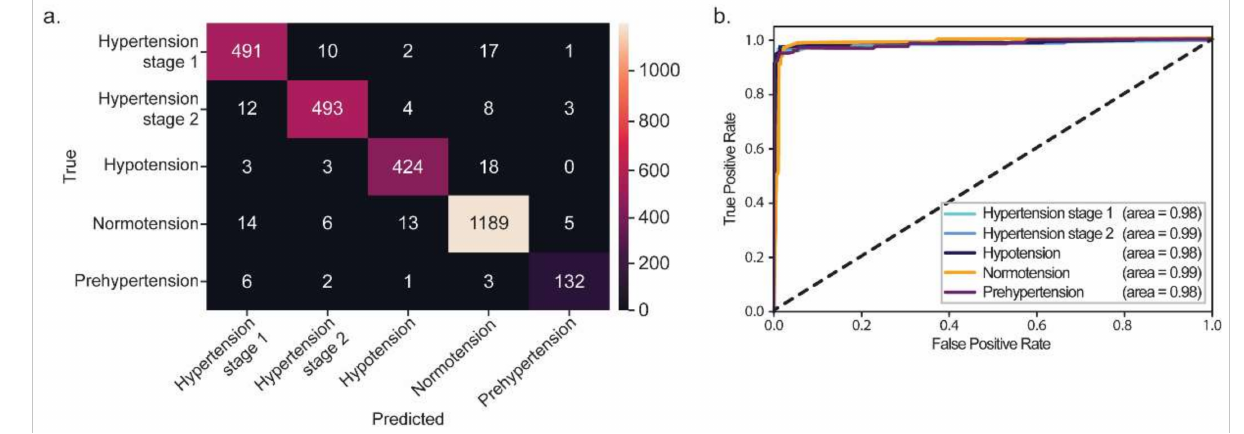
Figure 3. The performance results of test data. ( a ) Confusion matrix. ( b ) AUC score.